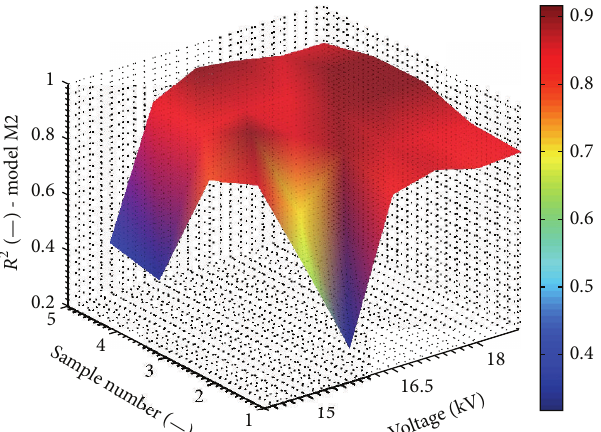
Figure 5: Comparison of values of 𝑅 2 coefficient obtained by the regression of the model M2 for all the recorded signals.